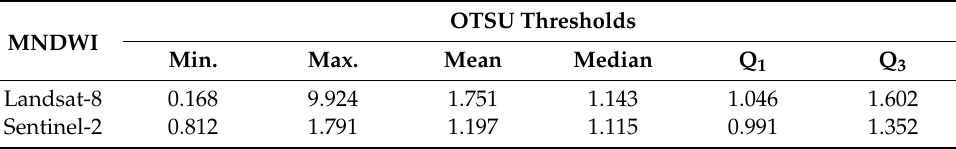
Table 6. Accuracy statistics from OTSU